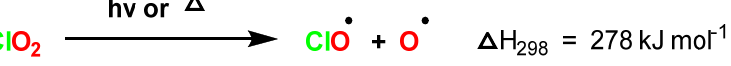
Figure 18. The homolysis of ClO 2 in neutral aqueous solution.